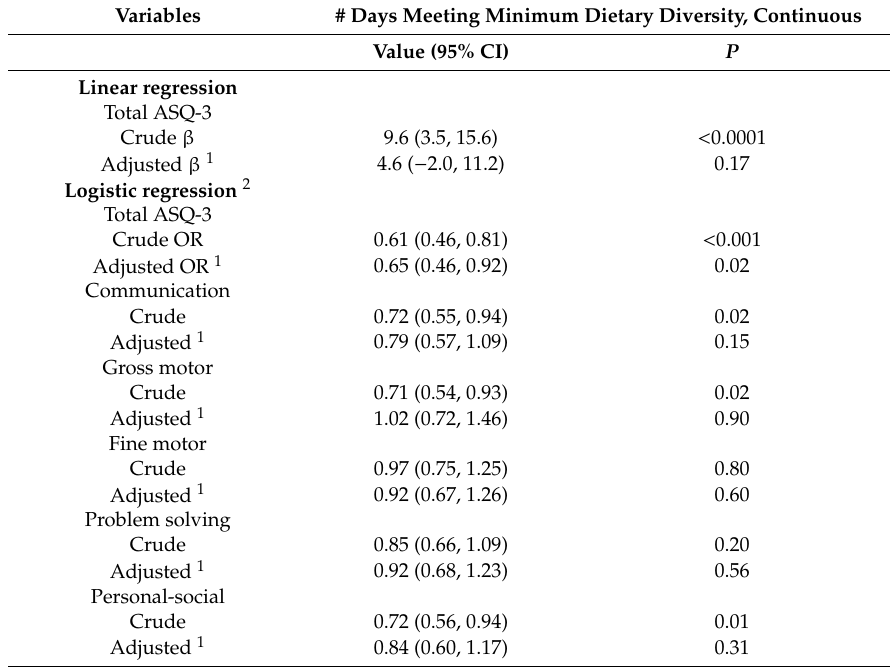
Table 4. Unadjusted and adjusted relationships between number of days meeting minimum dietary diversity over the three visits in early childhood and ASQ-3 scores (total and by domain), n =